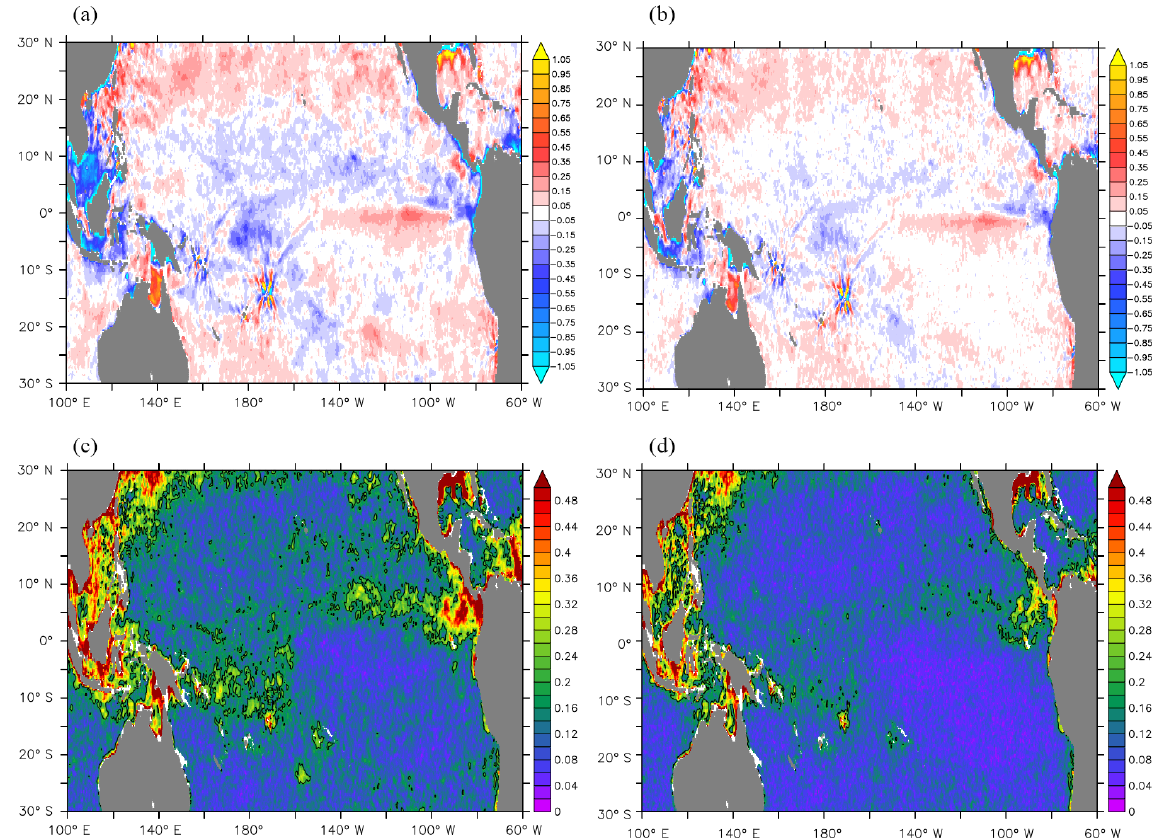
Figure 7. Mean difference (a, b) and root-mean-square difference (c, d) of monthly mean SSS (pss) with respect to the SMOS data (model minus SMOS) in the analysis fields in REF (a, c) and SMOSexp (b, d) experiments in the year 2015.